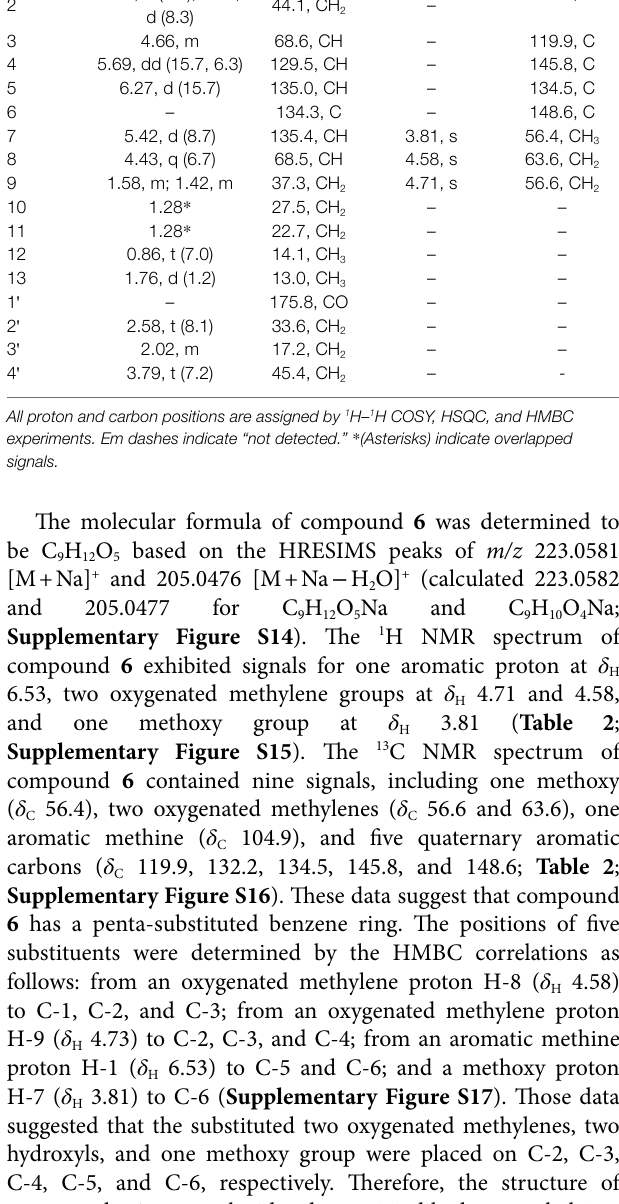
suggested that the substituted two oxygenated methylenes, two hydroxyls, and one methoxy group were placed on C-2, C-3, C-4, C-5, and C-6, respectively. Therefore, the structure of compound 6 was elucidated as 2,3-dihydroxymethyl-4,5- dihydroxy-6-methoxybenzene and named montenegrol.